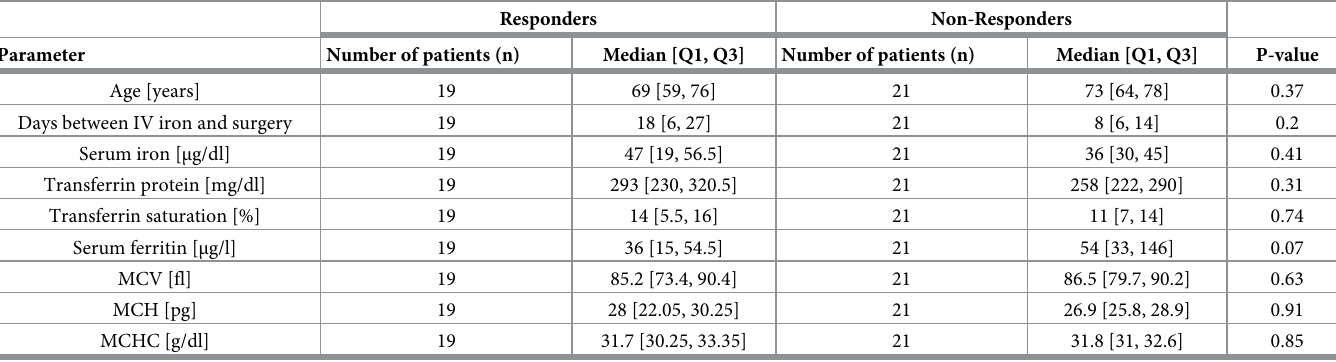
Table 2. Characteristics of responders and non-responders.